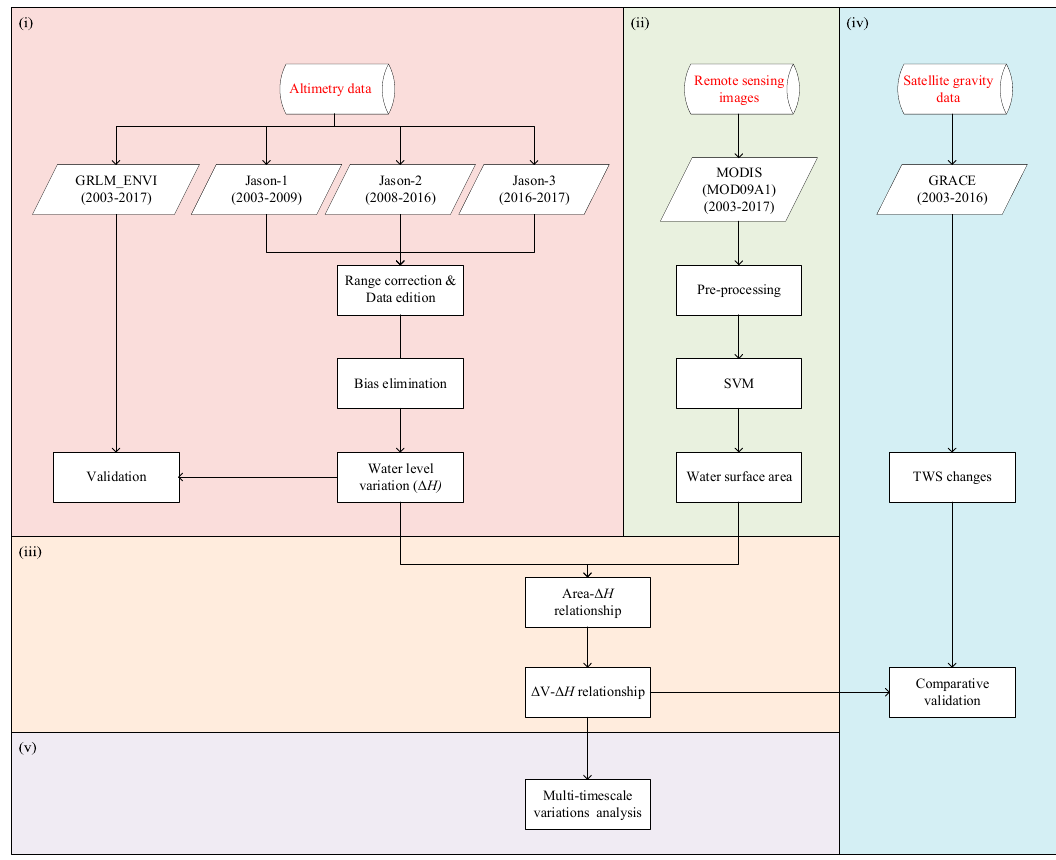
Figure 3. Technical route.